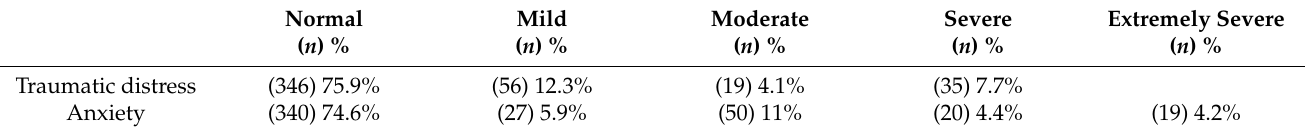
Table 2. Levels of anxiety, depression and traumatic distress related to COVID-19 in the study sample ( n = 456).